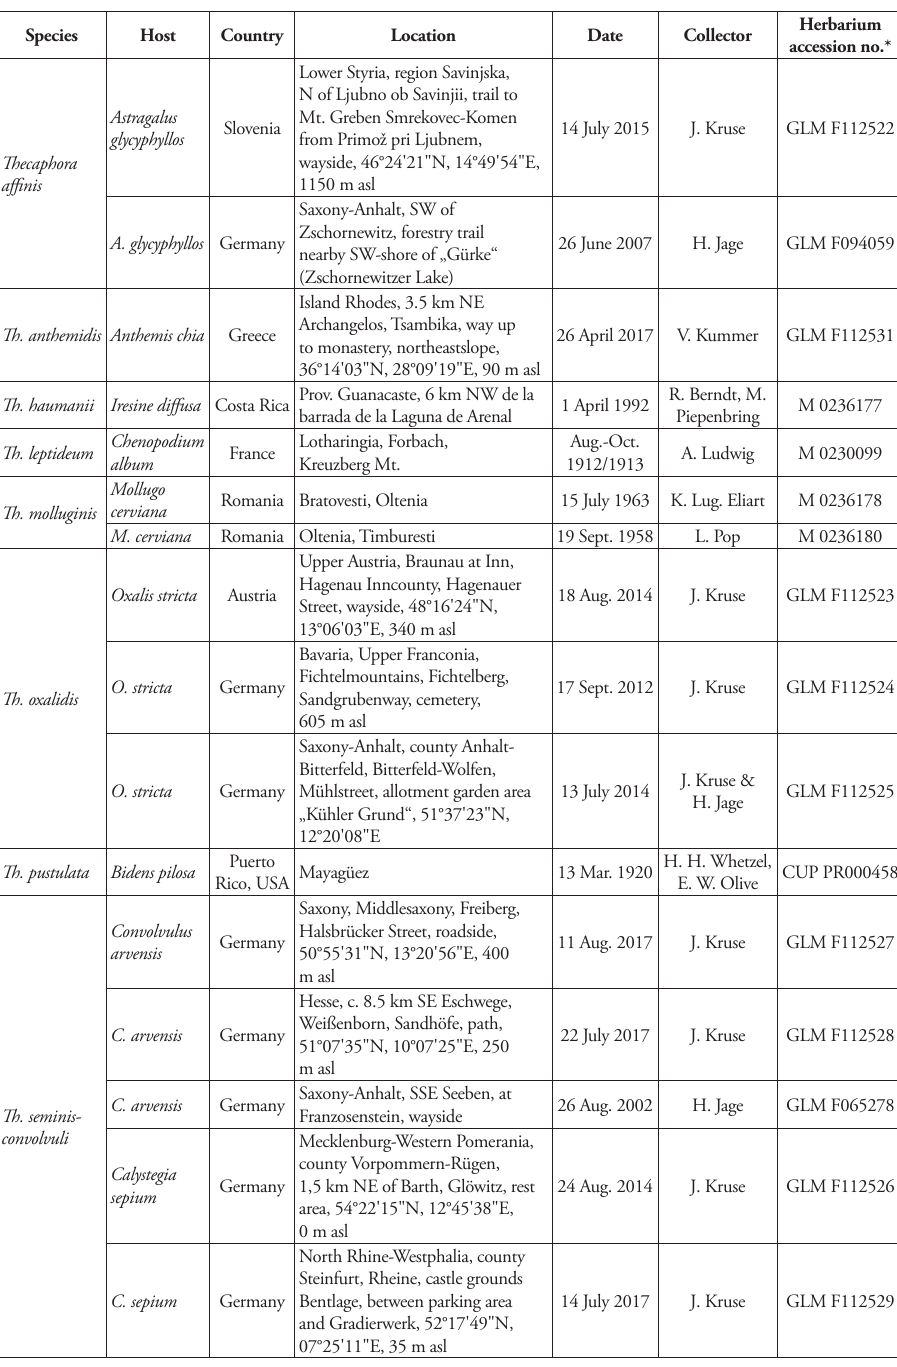
Table 1. Collection records for specimens of Thecaphora examined in this study.